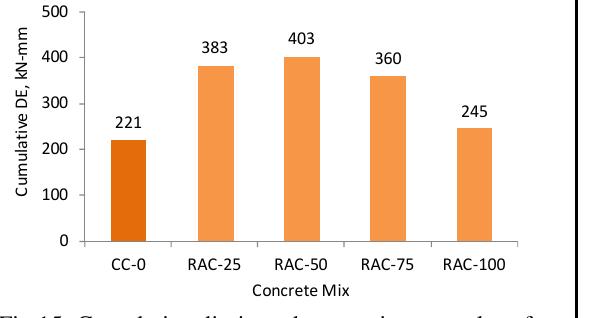
Fig.15: Cumulative dissipated energy in ten cycles of 5mm amplitude